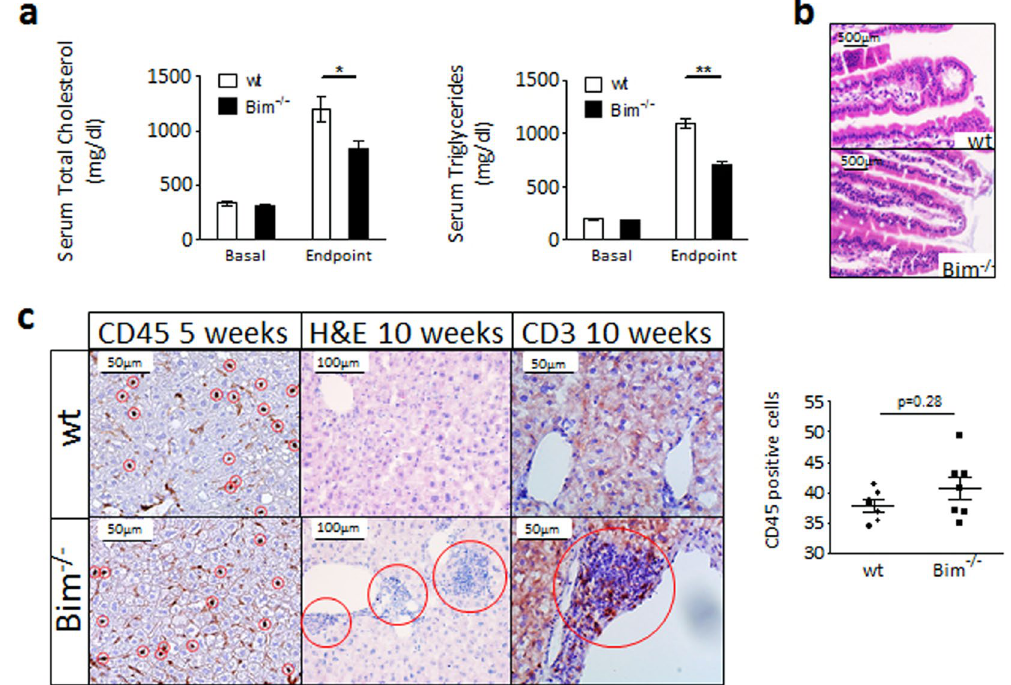
Figure 6. Lower cholesterol levels and liver infiltrates in bim − / − chimeric mice. ( a ) Cholesterol and Triglyceride levels in serum of wt and bim − / − chimeric mice after before (Basal) and after 10 weeks of WTD (Endpoint). N = 12. Mean + SEM are indicated. * p < 0.05, ** p < 0.01 ( b ) Representative images of H&E stained wt and bim − / − duodena show intac ρ t villi. ( c ) Liver sections of wt and bim − / − chimeric mice were analyzed